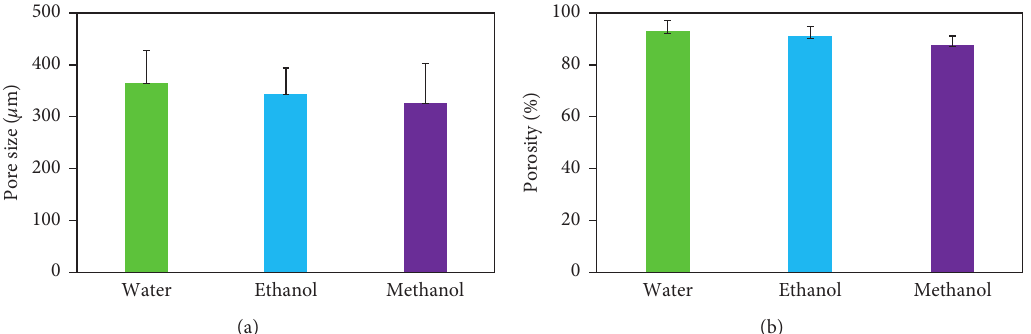
Figure 3: Pore size (a) and porosity (b) of silk scaffolds post-treated with methanol, ethanol, and